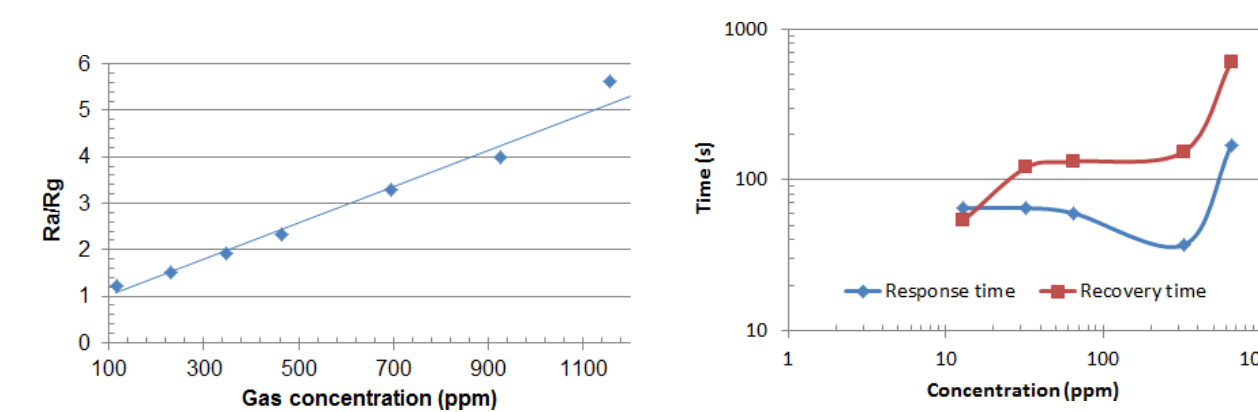
Figure 7. Dependence of the response of MWCNTs/SnO 2 PG and DMF vapor sensor on gas concentration measured at 200 ◦ C oper- ating temperature.